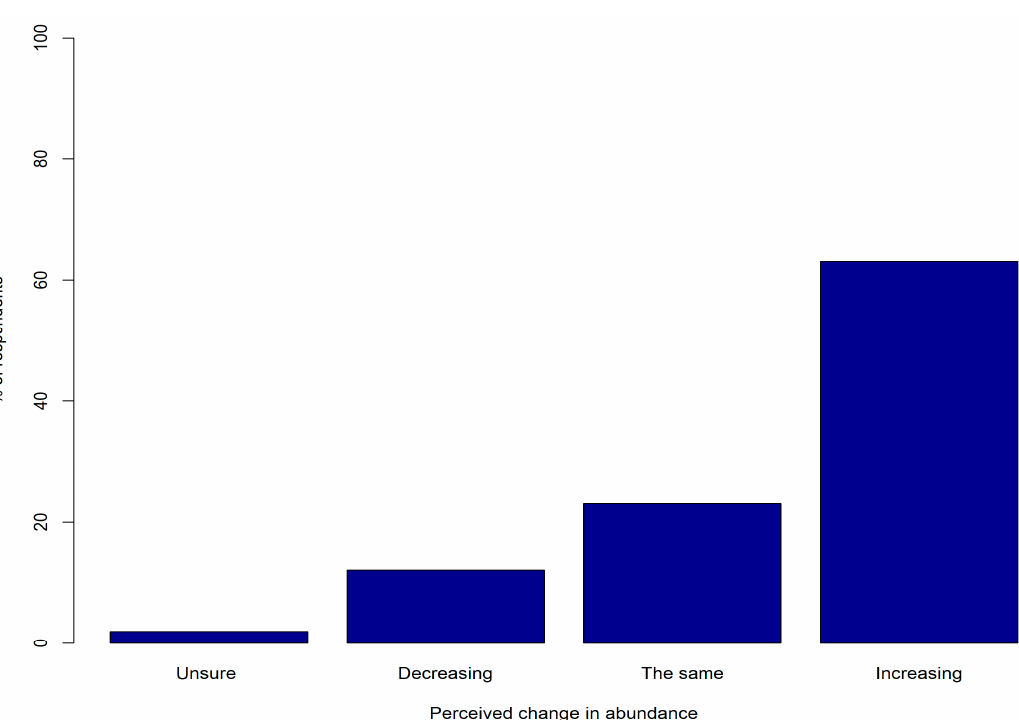
Figure 3. Perception of the change in abundance of aquatic plants in Lake Léman over the last 10 years.